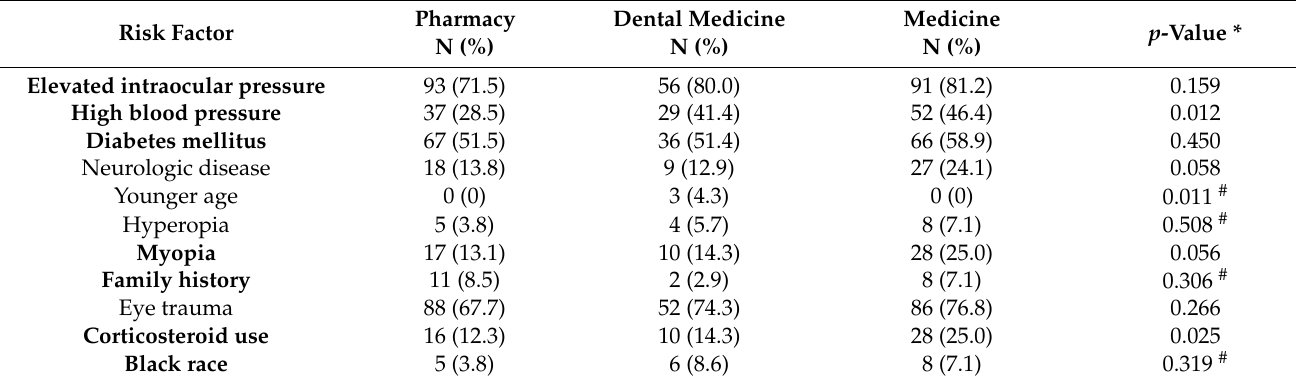
Table 2. Students’ knowledge of glaucoma risk